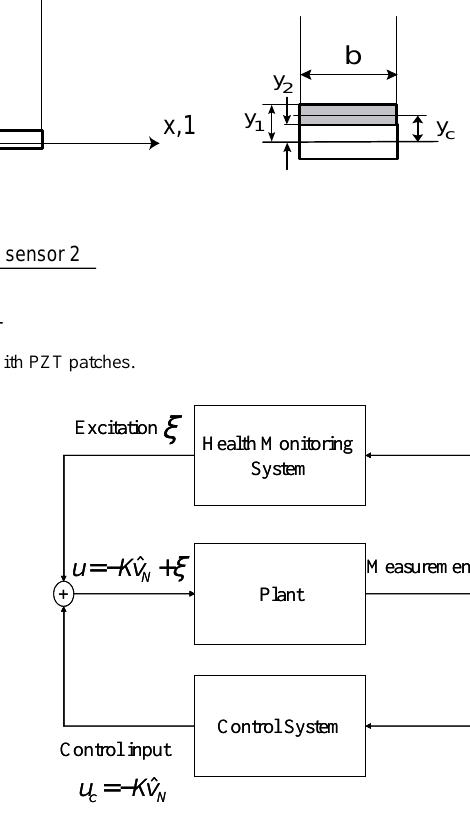
Fig. 5. The interaction of the closed-loop control system and the health monitoring